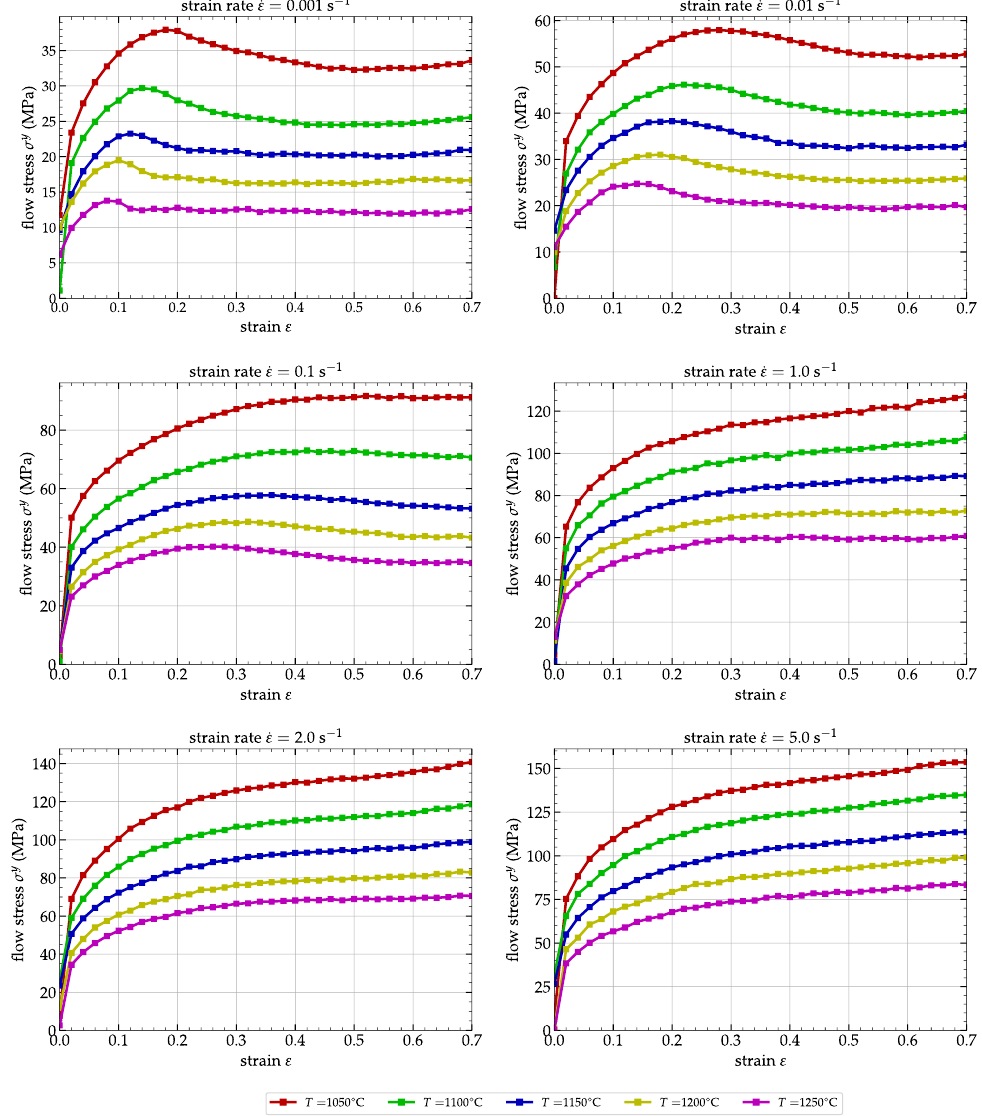
Figure 4. Stress–strain curves of medium carbon alloy extracted from the Gleeble device at various . ε temperatures T and strain rates